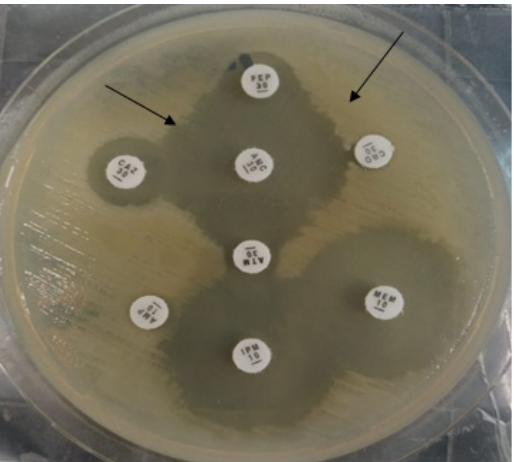
Figure 9. Black arrows indicate the double disc synergistic test for the production of ESBL